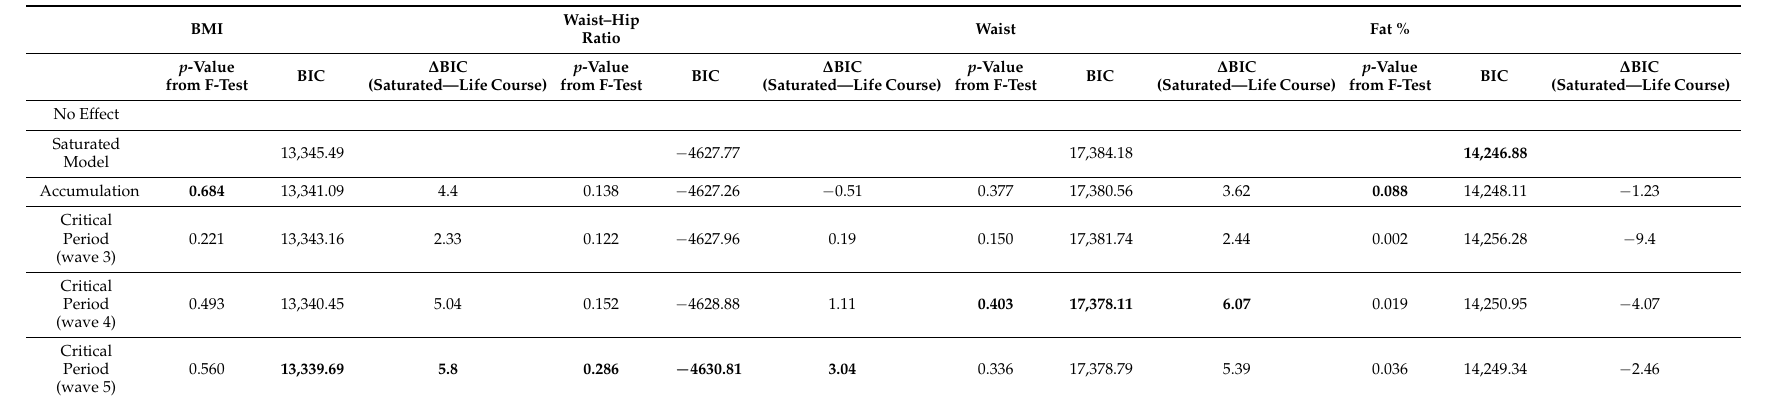
Numbers in bold indicate the best fitting model. Table 4. p -Values and Bayesian Information Criterion to assess the selection of the life course model for the relationship of neighbourhood perceptions over time with BMI, waist–hip ratio, waist circumference, and fat percentage (MEN ONLY).